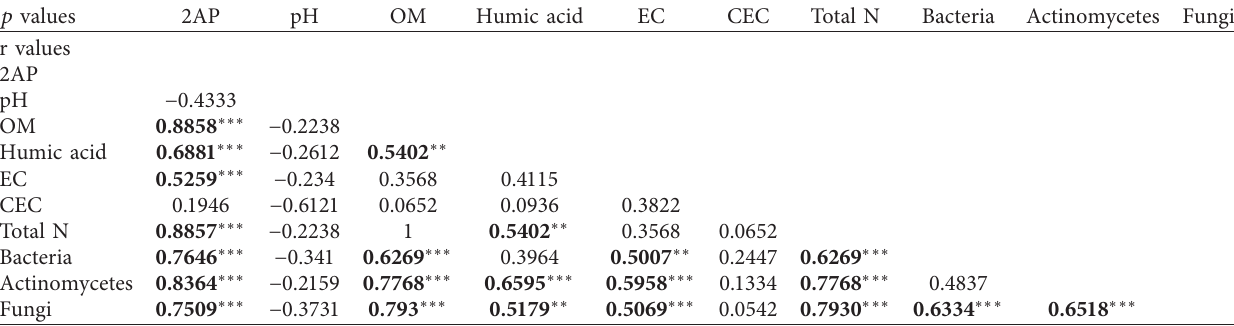
Table 2: Pearson’s correlation matrix for the 2-acetyl-1-pyrroline (2AP) concentrations, physicochemical properties, and soil microbial